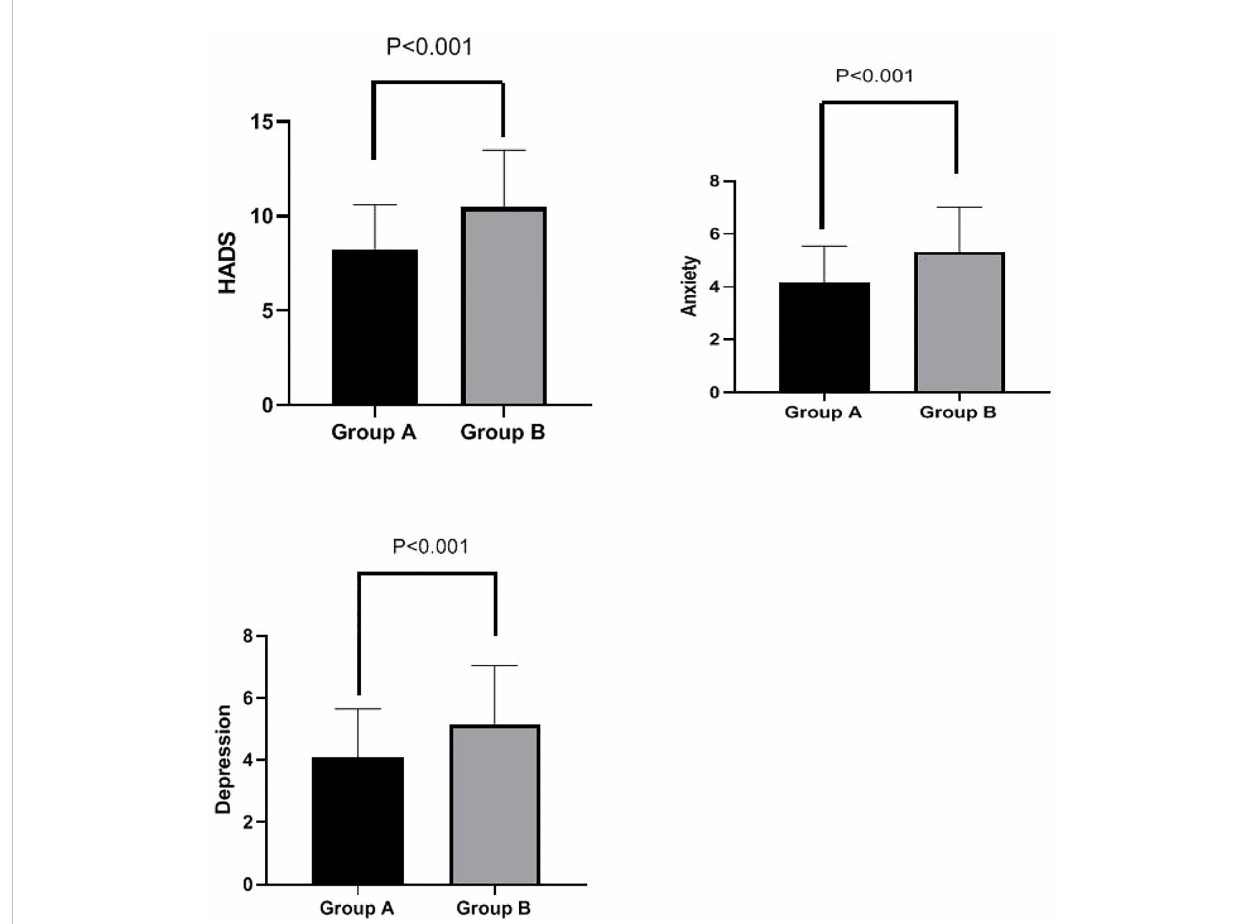
FIGURE 4 HADS total score, anxiety subscore, and depression subscore in Groups A and B at week 4. Total HADS scores were signi fi cantly lower in Group A than in Group B at week 4 (8.25 ± 2.36 vs. 10.48 ± 3.01, p < 0.001). Furthermore, anxiety scores (4.16 ± 1.38 vs. 5.33 ± 1.69, p < 0.001) and depression scores (4.09 ± 1.56 vs. 5.15 ± 1.89, p < 0.001) were both signi fi cantly lower in Group A than in Group B at week 4. HADS, Hospital Anxiety and Depression